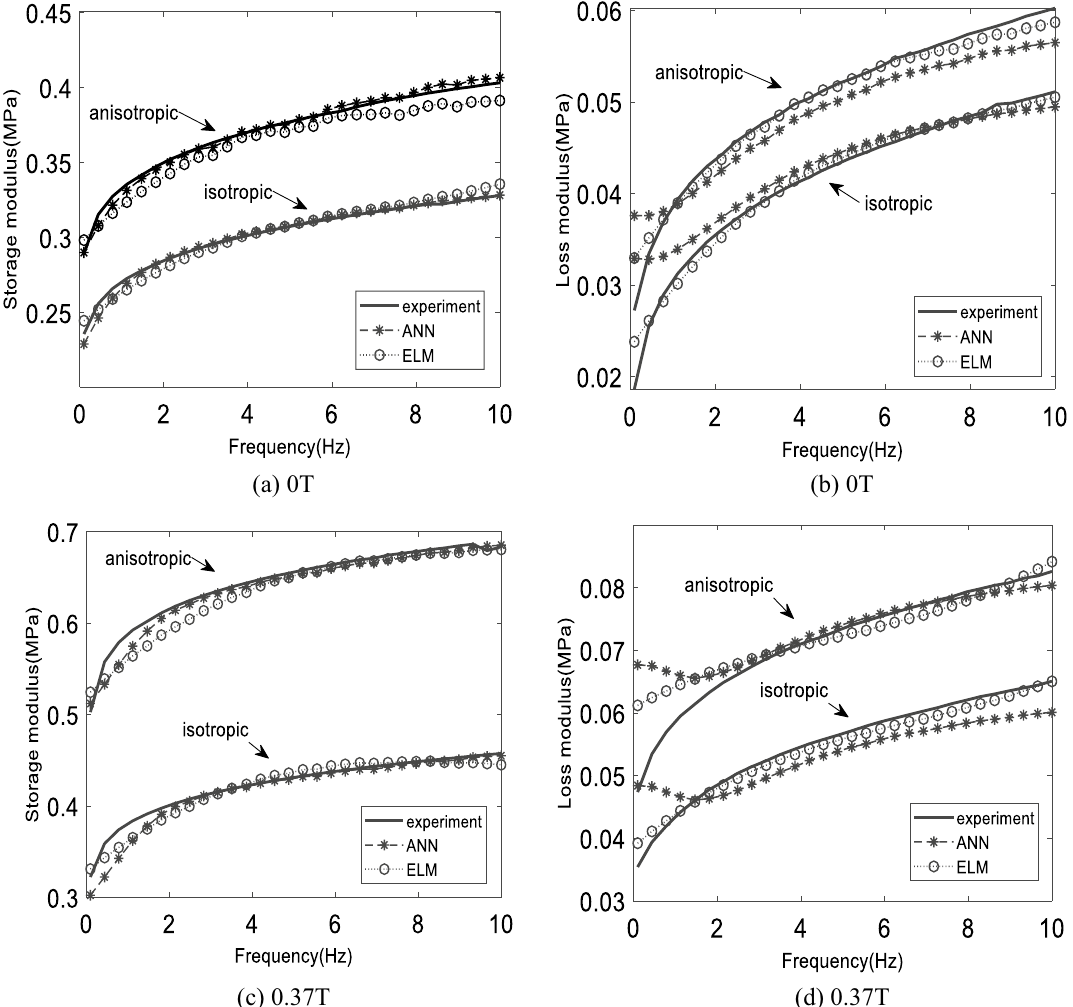
Figure 3. The comparison of dynamic moduli between experimental, ANN, and ELM model on 70% CIP where ( a ), ( b ) for learned 0 T, ( c ), ( d ) for learned 0.37 T for both